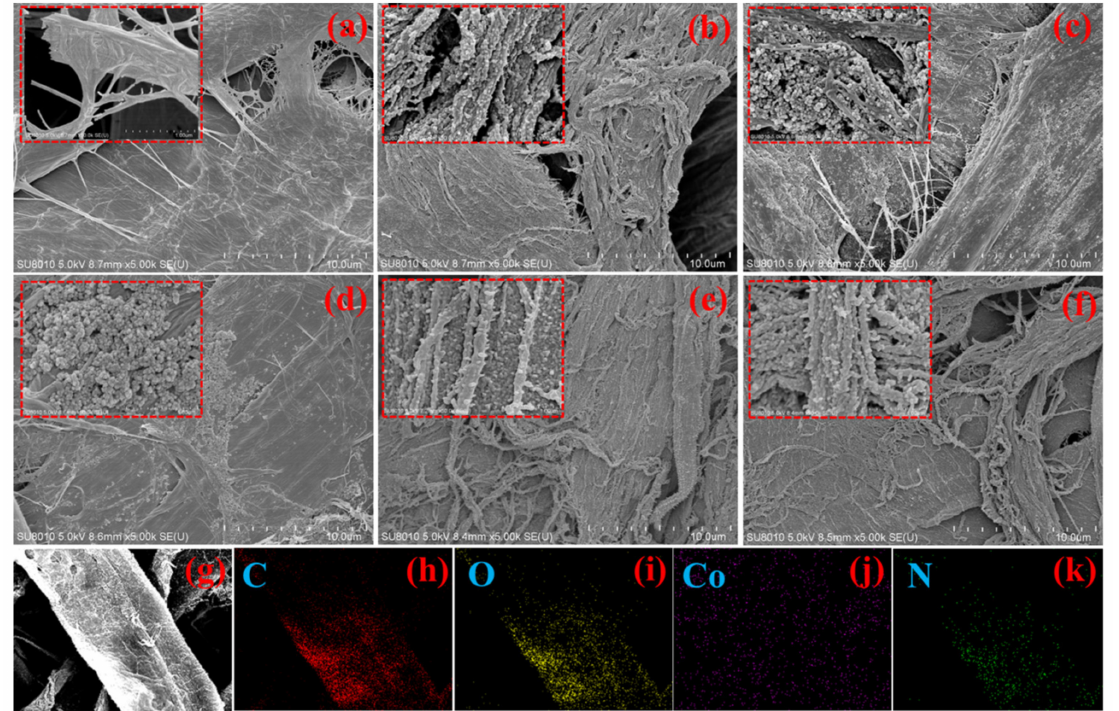
Figure 2. SEM images of cellulose fibers (CFs) ( a ), pseudo-capacitor materials (PC) ( b ), ZCC-1 ( c ), ZCC-2( d ), PZCC-1( e ), and PZCC-2 ( f ). Elemental mapping of PZCC-2 ( g – k